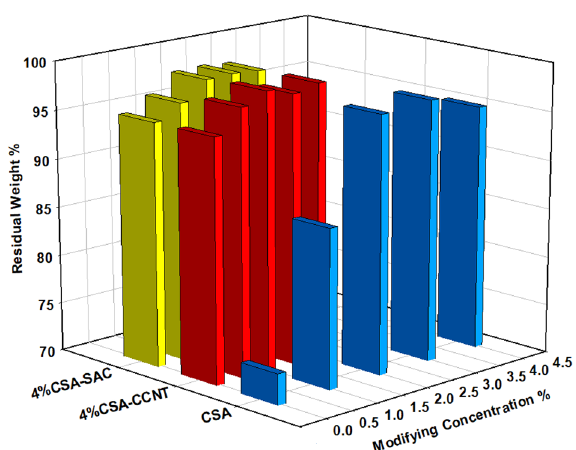
Figure 8. Oxidation stability of CMC/PVA/AA and modified CMC/PVA/AA hybrid polyelectrolytic membranes with different amounts of CSA, CCNT and